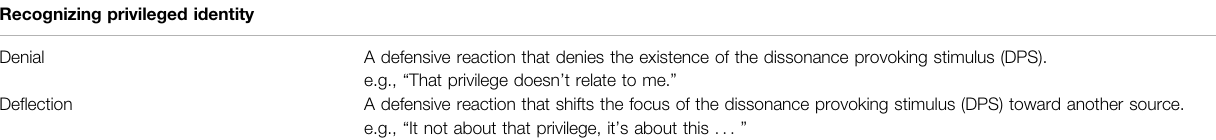
TABLE 1 | Description of privileged identity exploration model constructs with associated defenses (Watt, 2015). Recognizing privileged